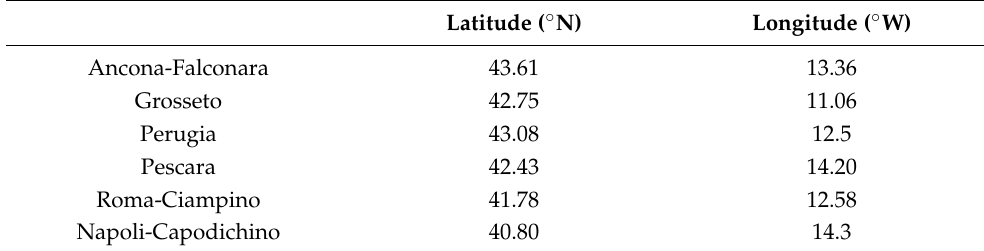
Table 2. Coordinates of reference observational